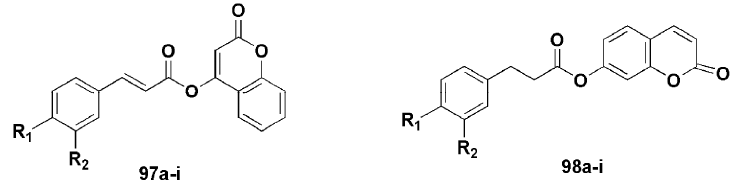
Figure 26. Chemical structures of coumarin derivatives ( 97a–i and 98a–i ) [69].